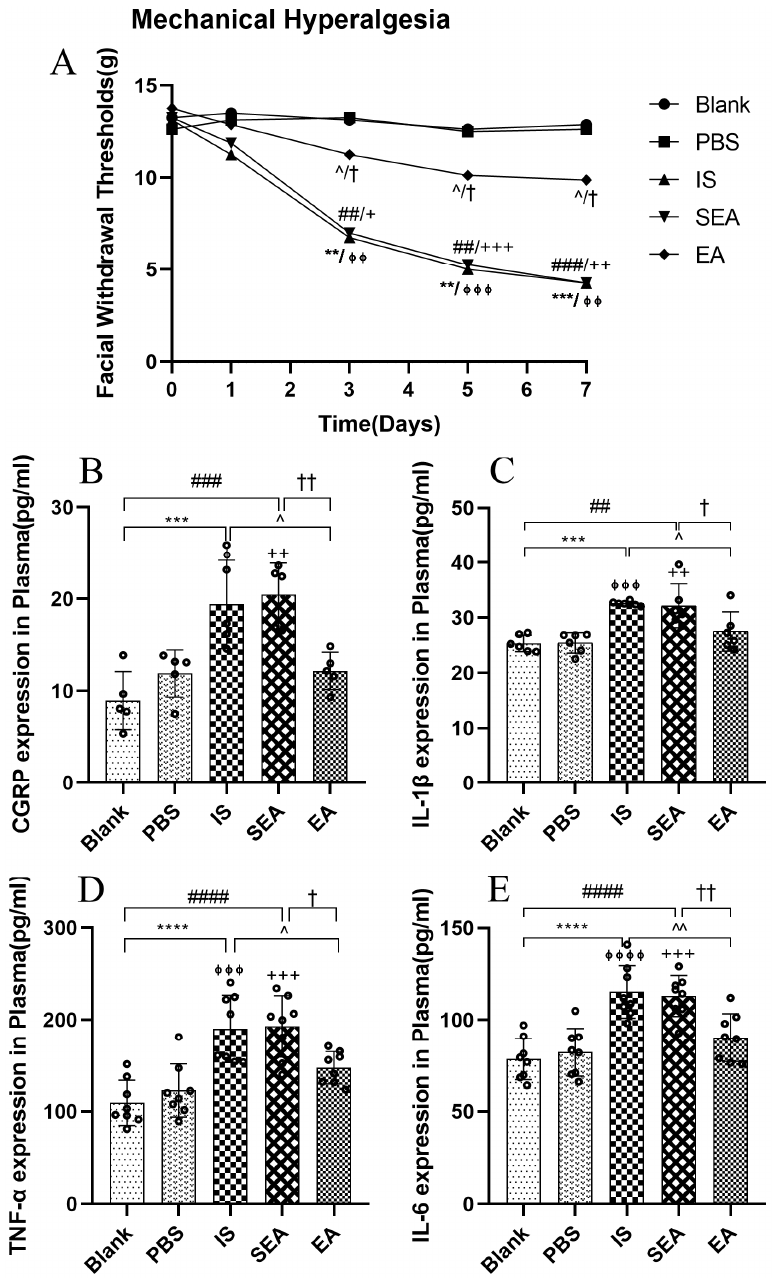
Figure 2. ( A ) The changes in facial mechanical withdrawal thresholds in the five groups of rats ( n = 8/group). Repeated daily IS ‐ dural administrations induced basal mechanical response decreases ( n = 8/group). Repeated daily IS-dural administrations induced basal mechanical response decreases and EA treatment at GB20/34 alleviated the facial mechanical withdrawal thresholds in rats following dural IS stimulation. Plasma levels of CGRP ( B ) and inflammatory cytokines, including IL-1 β ( C ), TNF- α ( D ), and IL-6 ( E ), in the five groups of rats detected by ELISA ( n = 6–8/group). Repeated IS infusions into dura increased the release of CGRP and the above inflammatory cytokines, while EA decreased plasma levels of CGRP and inflammatory cytokines. Kruskal–Wallis test was used to analyse facial mechanical withdrawal thresholds followed by Dunn’s multiple comparisons. ANOVA followed by Tukey’s post hoc analysis test were used to analyse ELISA data. Data are presented as the mean ± standard deviation. ** p < 0.01, *** p < 0.001, **** p < 0.0001, Blank vs.